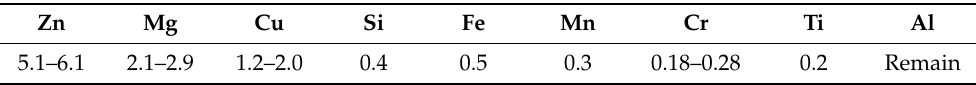
Table 1. Main chemical composition (in wt%) of aluminium alloy